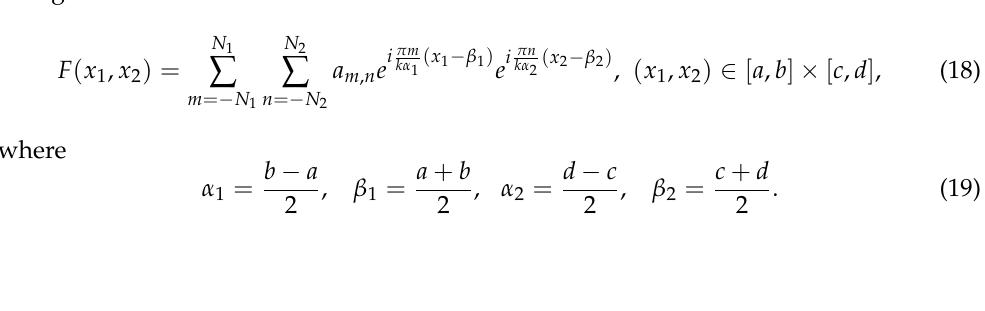
Figure 3. Distribution of Gauss–Lobatto nodes in [ − 1,1] × [ − 1,1]. For function